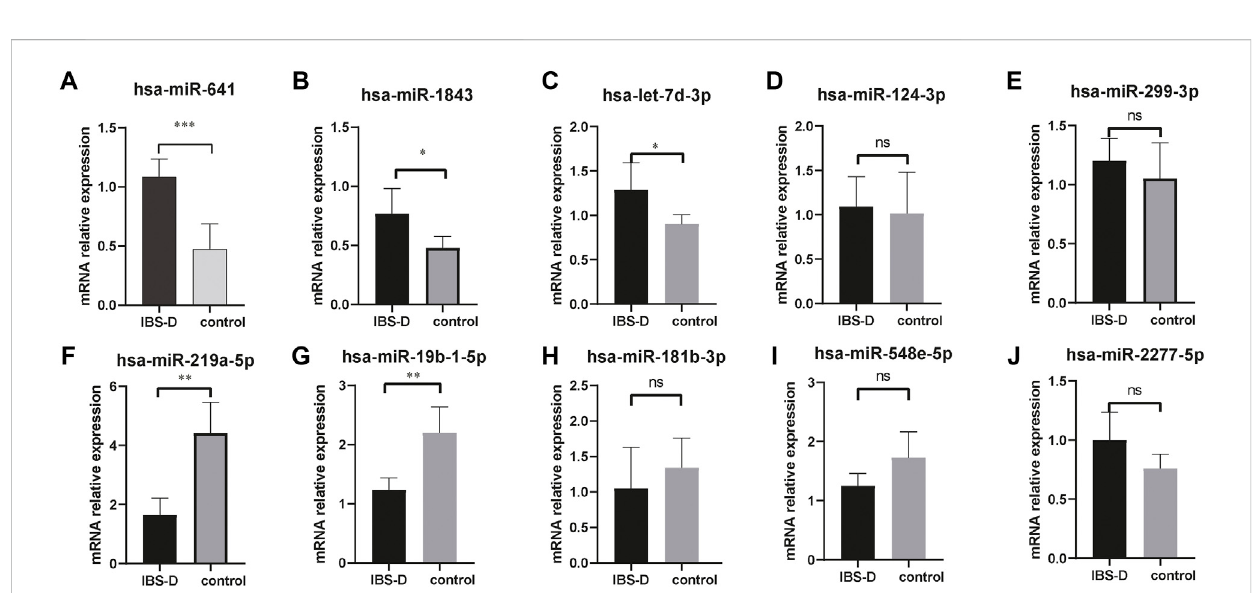
FIGURE 2 q-PCR veri fi cationof differential miRNAs. The mRNA expressions ofhsa-miR-641,hsa-miR-1843, and hsa-let-7d-3pweresigni fi cantly increased in IBS-D patients (A – C) .The mRNA expressions ofhsa-miR-219a-5p and hsa-miR-19b-1-5p weresigni fi cantly reduced (F,G) .No signi fi cant differences for other miRNAs (D,E,H,I,J) . * p < 0.05; ** p < 0.01; *** p < 0.001. IBS-D group versus control